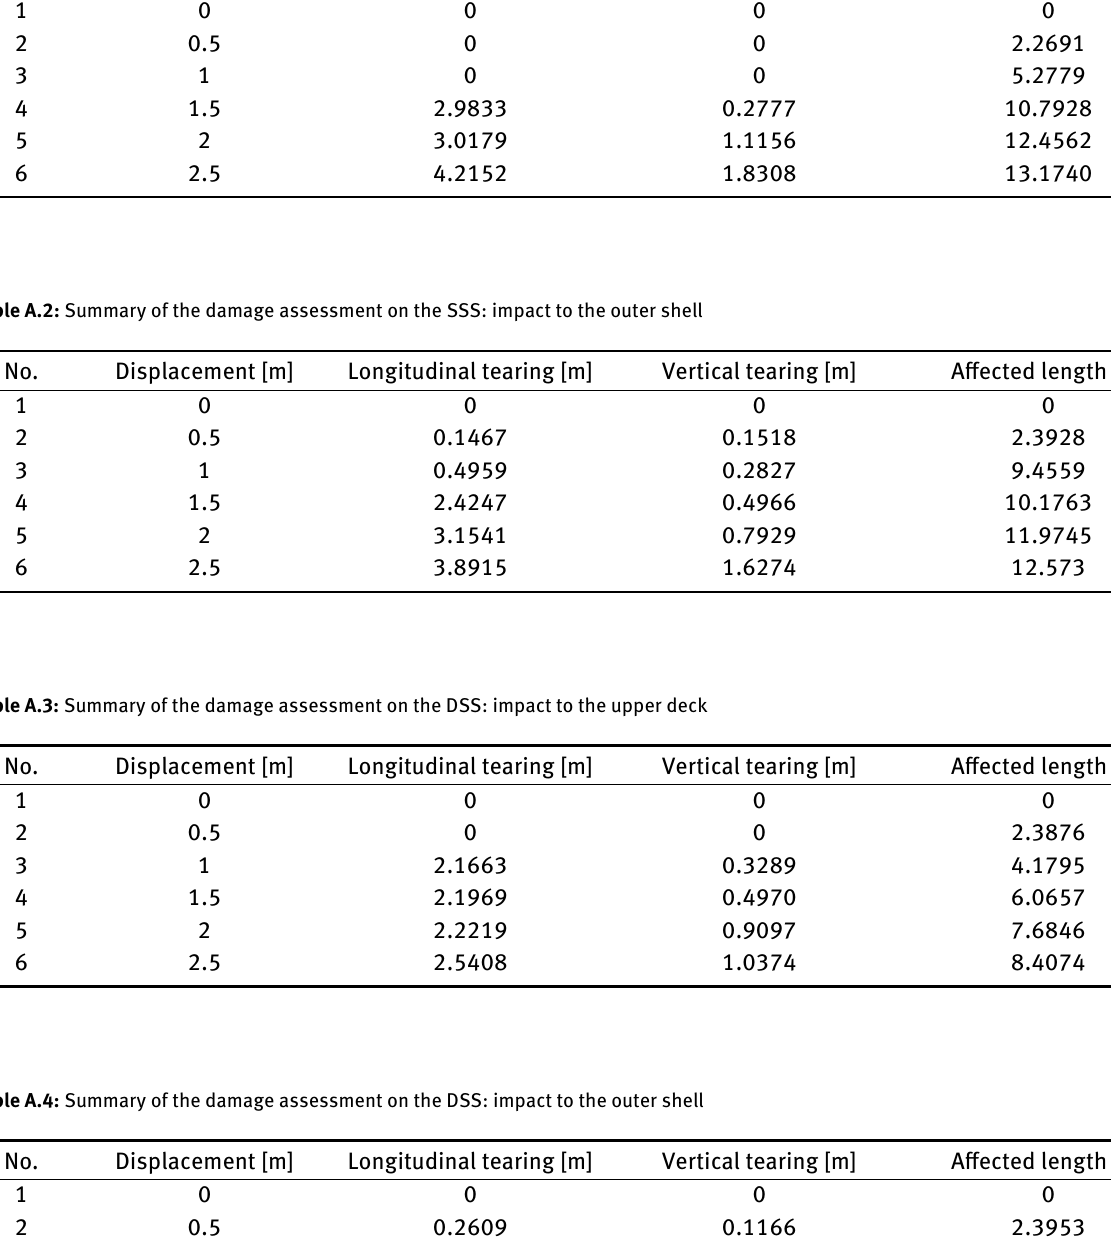
Table A.1: Summary of the damage assessment on the SSS: impact to the upper deck No.